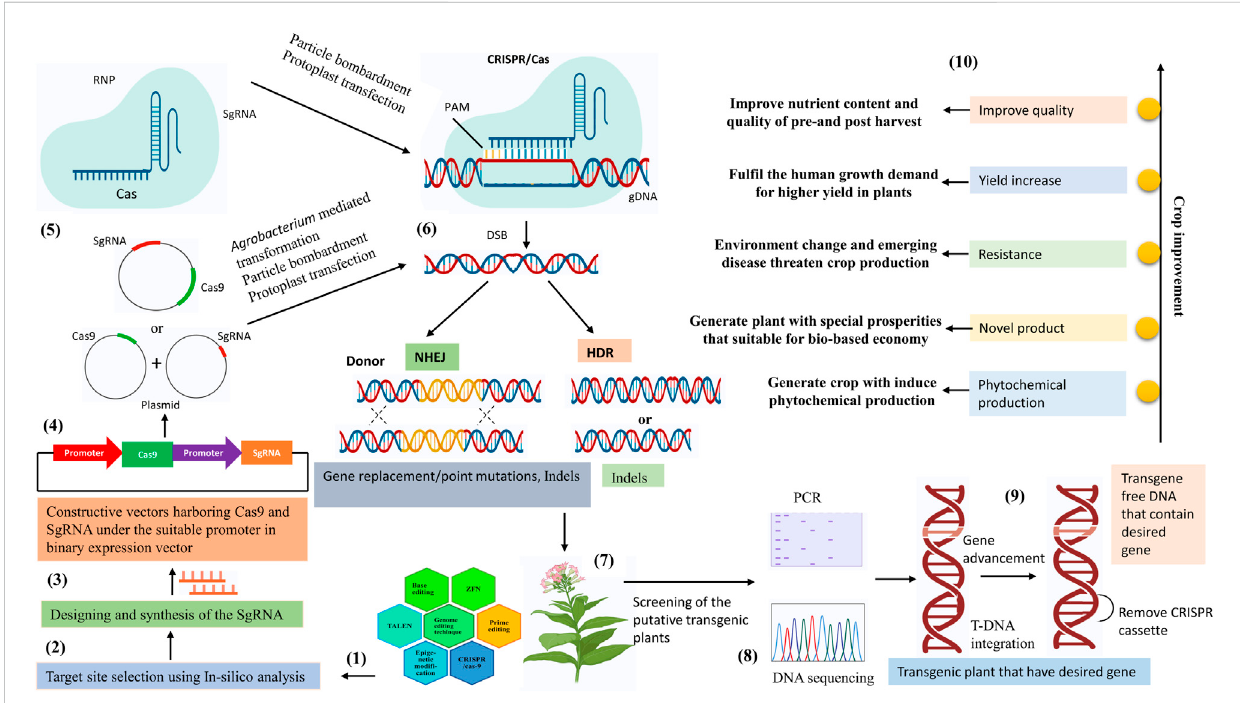
FIGURE 1 Overview of the CRISPR/Cas9 mediated genome editing in the plant. (1) Genome editing techniques. (2) Selection of the genomic target using In- silico analysis. (3) Design the sgRNA complementary to the target sequence. (4) Cloning of the designed Cas9 and sgRNA under suitable promoter in the binary expression vector. (5) The components of CRISPR/Cas9 tools construct transfer into plant cells, via Agrobacterium- mediated transformation, protoplast transfection, and particle bombardment. (6) CRISPR/Cas9 tools mediated genome editing in plants depend on the two main DSB (double-strand break) pathways. Gene replacement/point mutations, and indels are outcomes of the NHEJ (non-homologous end joining) pathway. Gene indels are outcomes of the HDR (homology-directed repair) pathway. (7) Development of the transgenic plant. (8) Identify the mutations in transgenic plants using DNA sequencing and PCR restriction enzyme assays and genotyping the transgenic plant with the desired mutation. (9) Removal of the CRISPR/Cas9 cassette (10) Crop improvement by the CRISPR/cas9